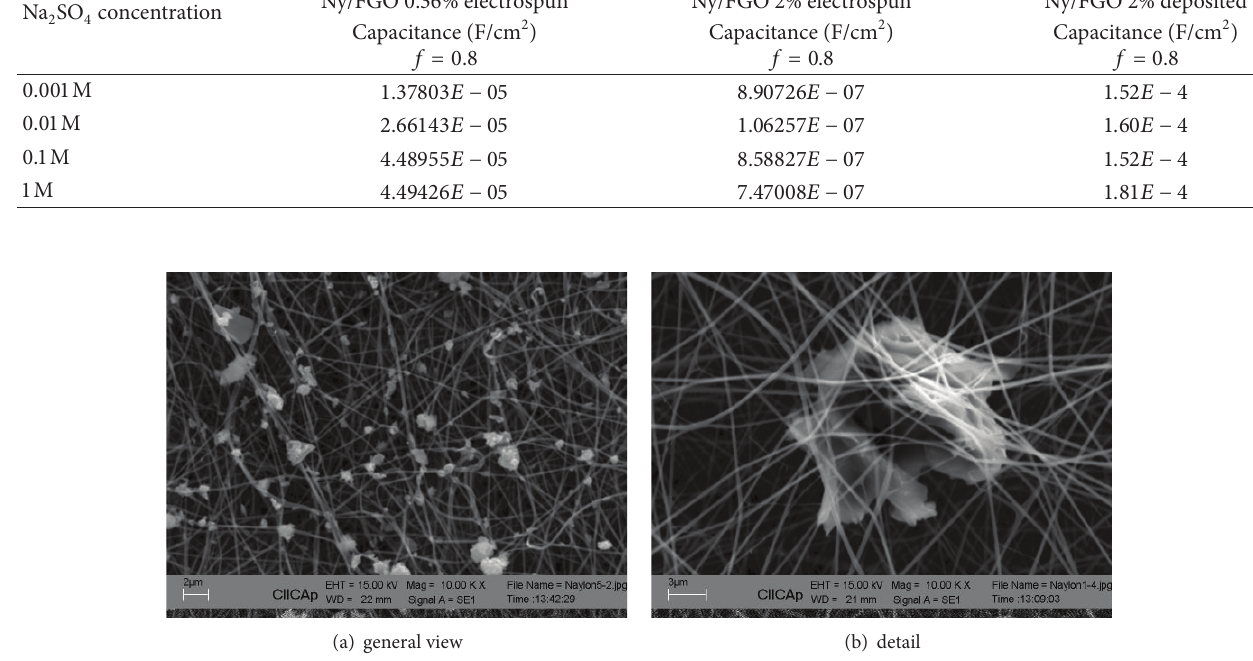
Figure 10: SEM of electrospun Ny/FGO composite at 10k x magnification.